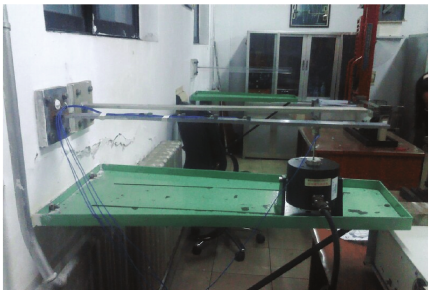
Figure 20: The cantilever beam structure of SISO